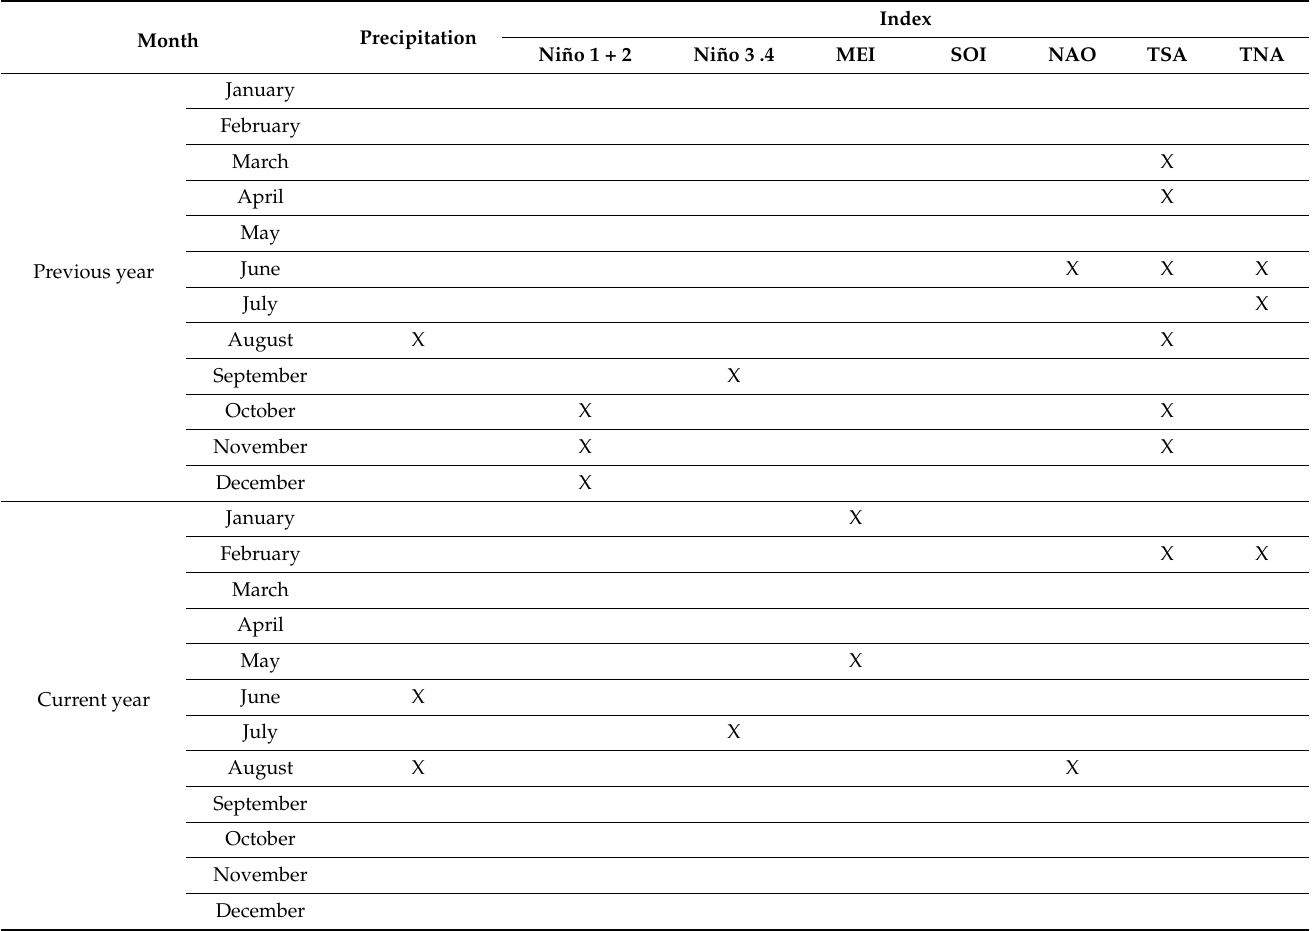
Table 2. Precipitation and ENSO